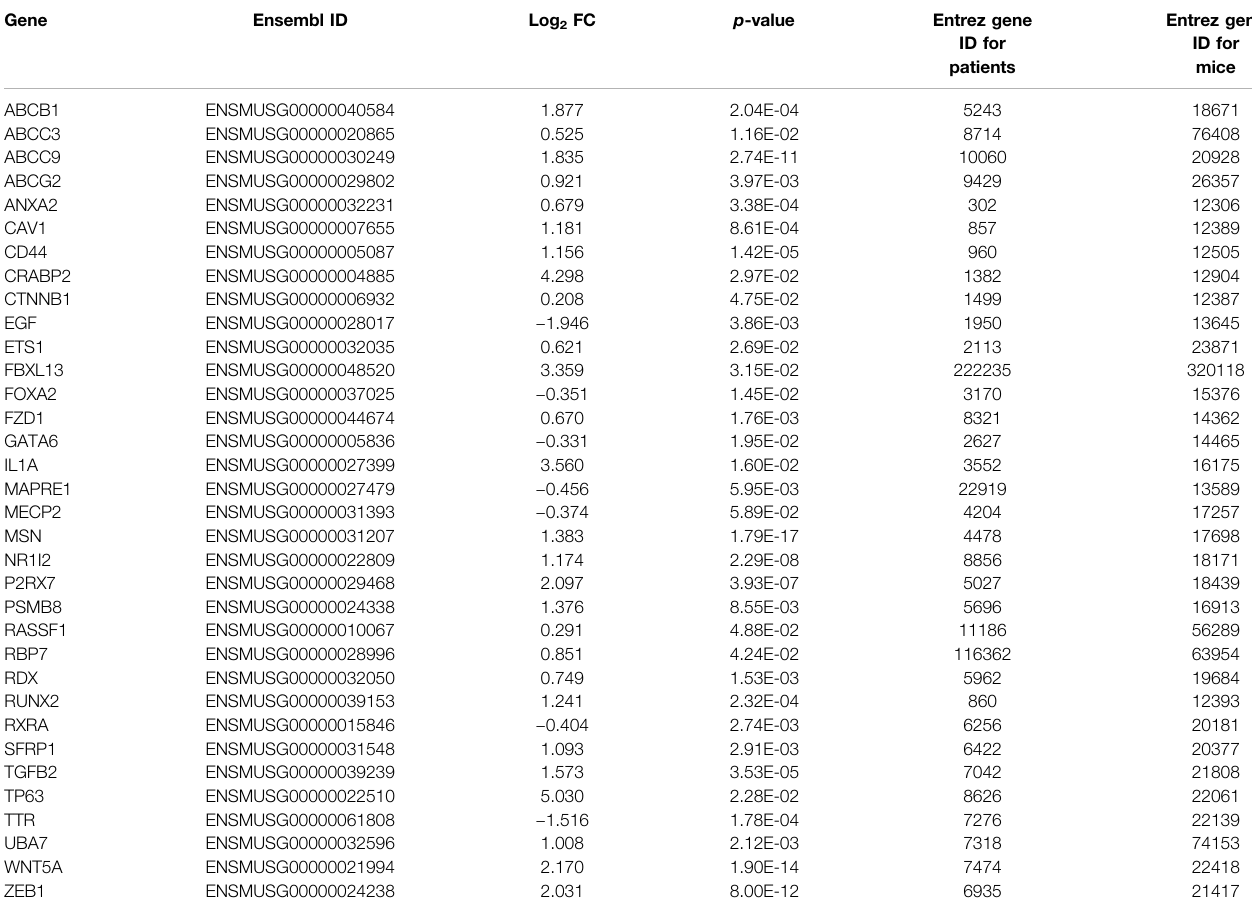
TABLE 3 | Gene expression in networks comprised of ivermectin interactions and WNT/ β -catenin signaling pathways in mouse gastric cancer (as presented in Figure 4A ).